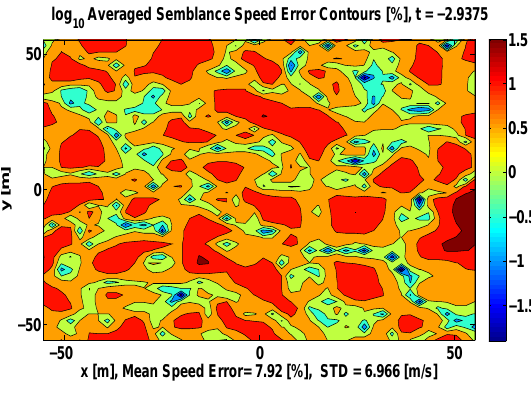
( p ) , where p is speed percent relative error. Lower color bar units e e 10